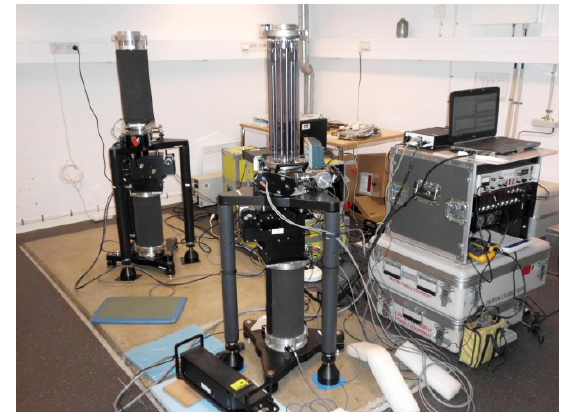
Figure 3: OSO absolute gravity site with the absolute gravimeter FG5X-220 (point AA, room center) of LUH and FG5-233 (AC) of